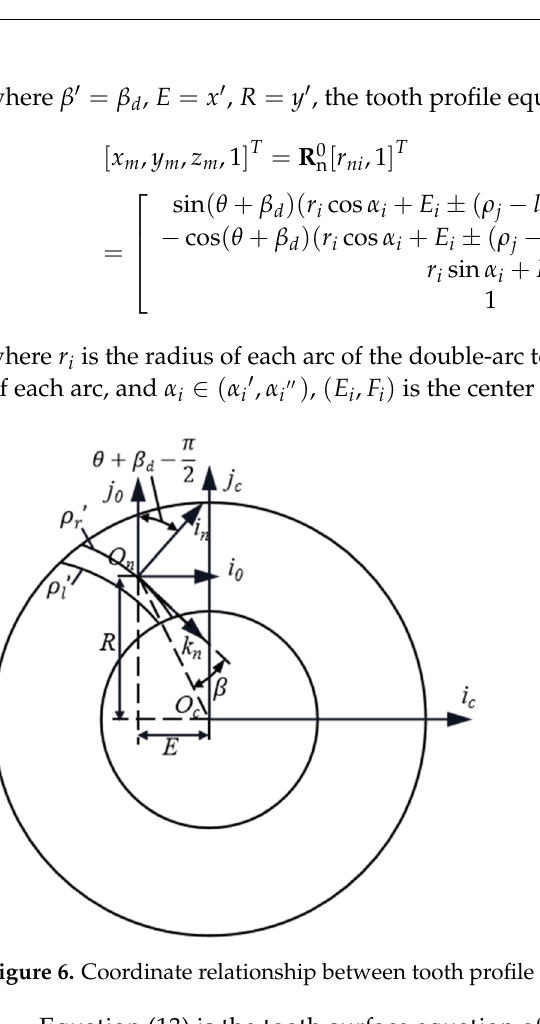
y , the tooth profile equation of the crown gear is: